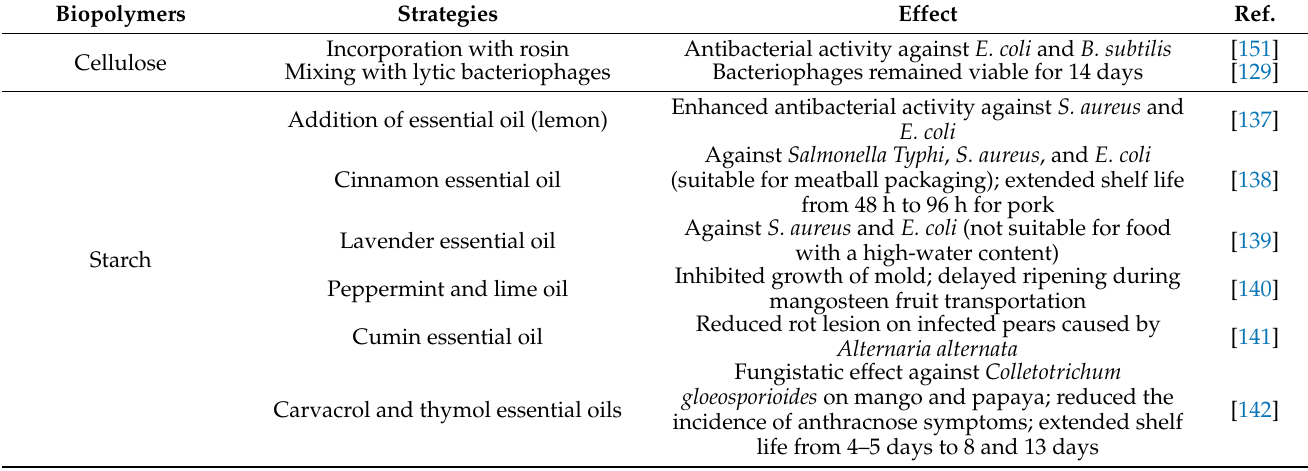
Table 3. The application of biopolymers with antibacterial activity for food